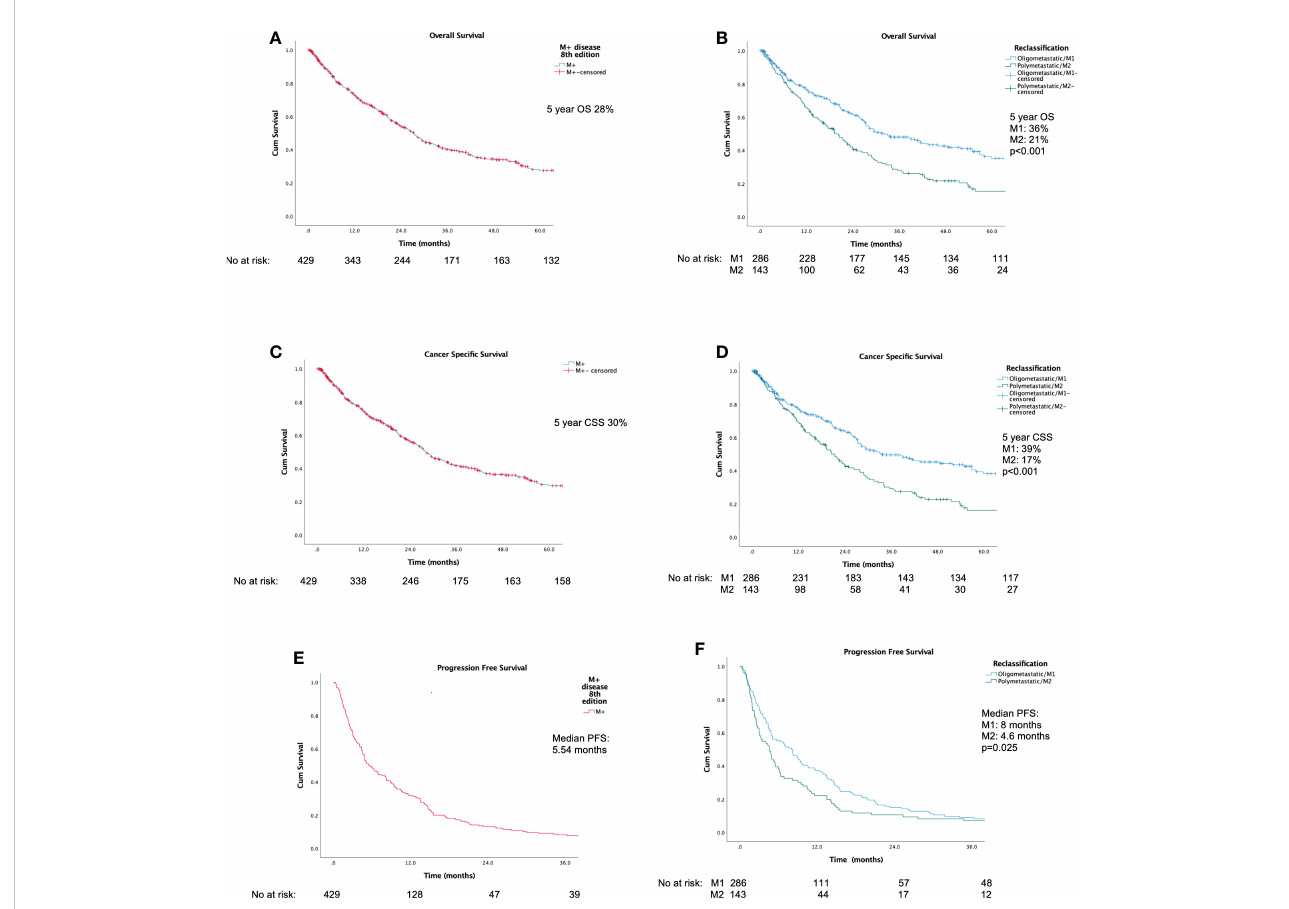
FIGURE 2 Kaplan-Meier survival analyses: (A) Overall Survival for current unitary M+ classi fi cation; (B) Overall Survival for proposed M1/M2 Subgroups; (C) Cancer- Speci fi c Survival for current unitary M+ classi fi cation; (D) Cancer-Speci fi c Survival for M1/M2 Subgroups; (E) Progression-Free Survival for current unitary M+ classi fi cation; (F) Progression-Free Survival for M1/M2